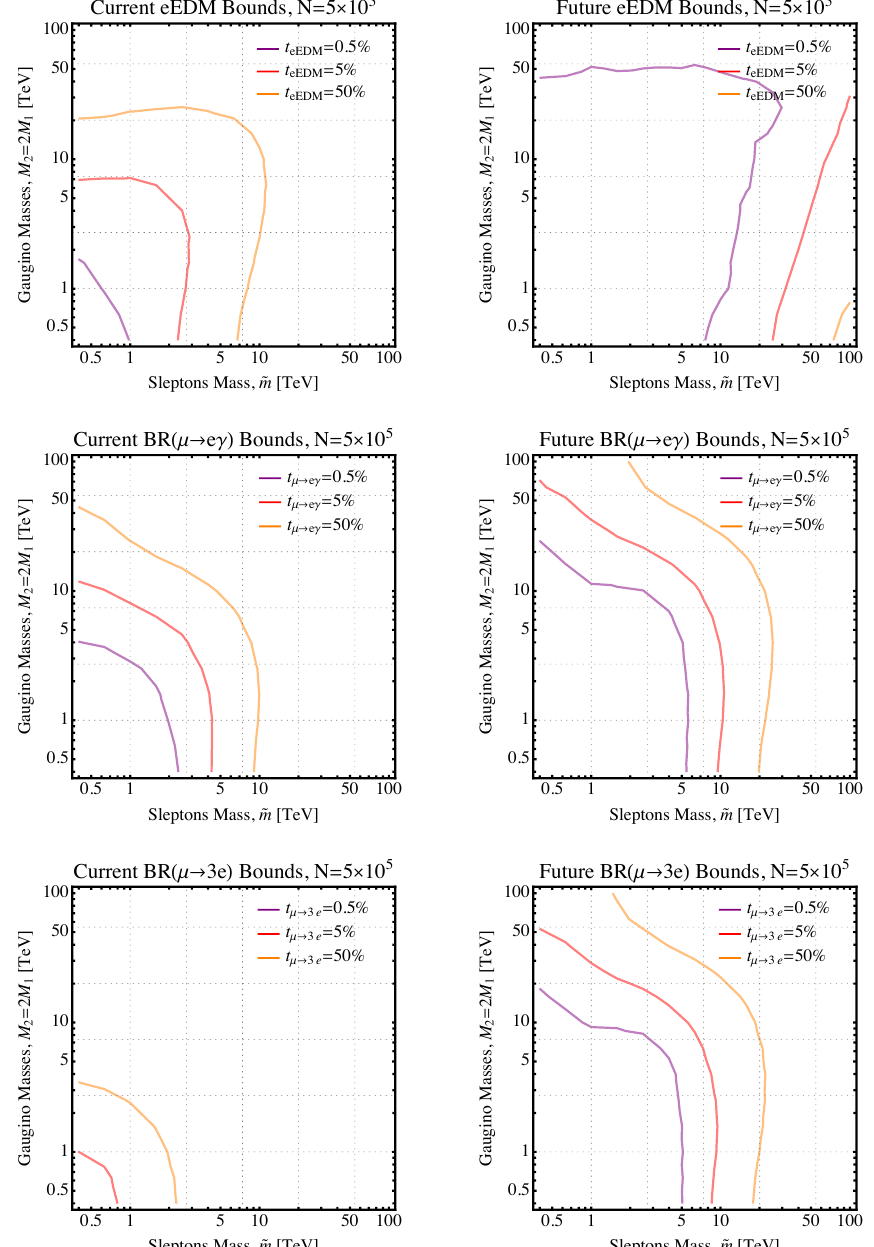
Figure 7 . Similar to figure 3 but for the charge assignment [ S 2 ] = − 4 and { [ L 1 ] , [ L 2 ] , [ L 3 ] , [¯ e ] , [¯ e ] , [¯ e ] } = { 4 , 3 , 2 , 4 , 1 , 1 } (the fifth row of table 1 2 3